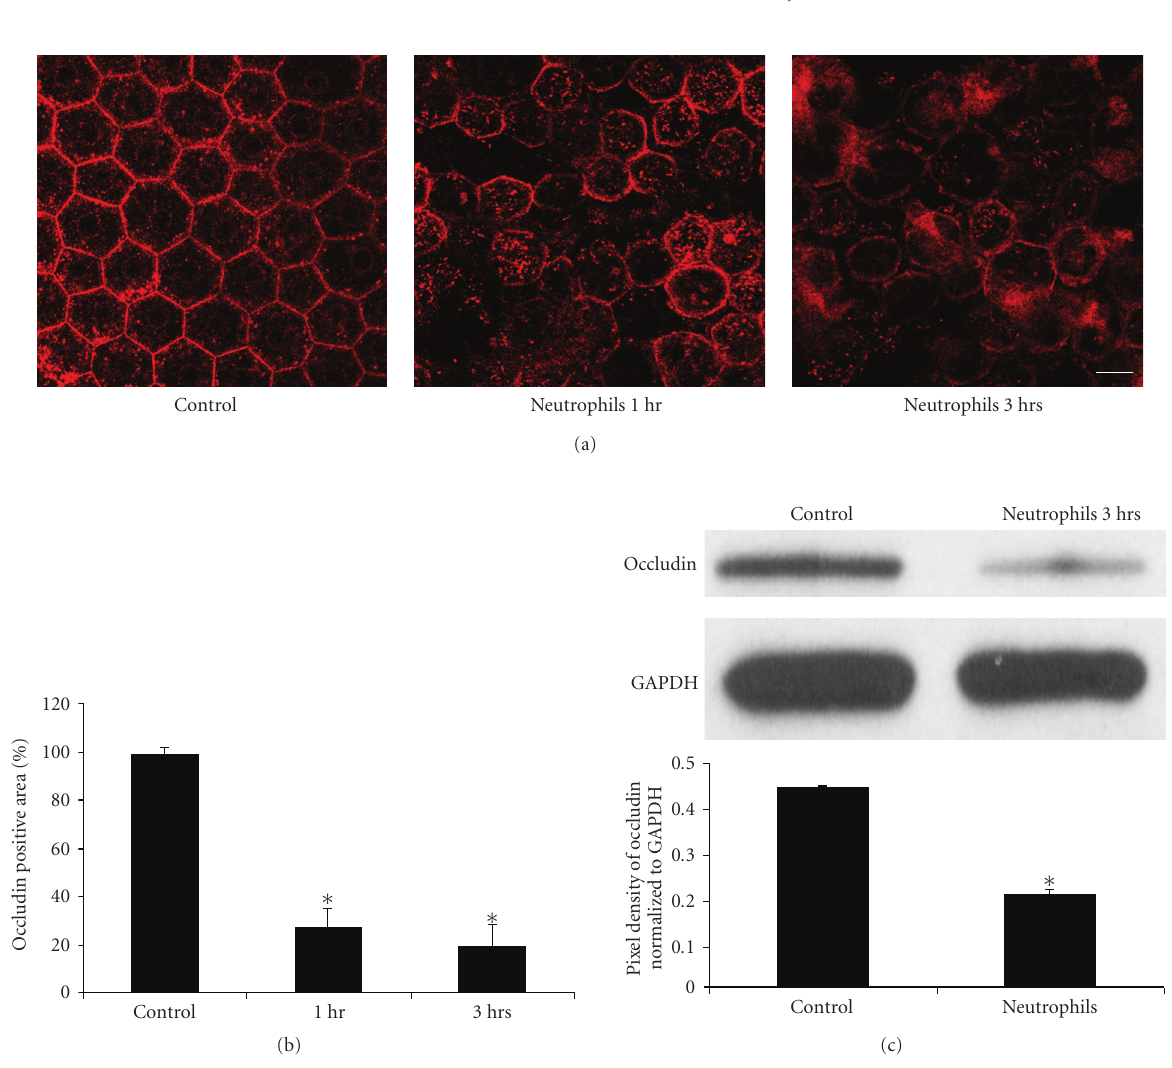
Figure 3: Neutrophils induced disruption of tight junction protein occludin in the RPE monolayer. (a) Occludin immunofluorescence staining on RPE-Choroidal explants. (b) Quantative analysis of occludin immunofluorecence area on RPE–Choroidal explants. Bovine RPE-Choroidal explants were incubated with neutrophils for 1–3 hours at 37 ◦ C. Occludin expression was determined by confocal immunomicroscopy using anti-ZO-1 Ab. Quantitation of occludin staining positive area was analyzed by using LSM 510 image software. ∗ represents P < . 01. Bar = 50 μ m. (c) Western blot shows the e ff ects of Neutrophils on occludin expression after 3-hour incubation. In (c), the result of densitometry from the western blot (upper panel), normalized to GAPDH, shows significant loss of occludin protein, P < .